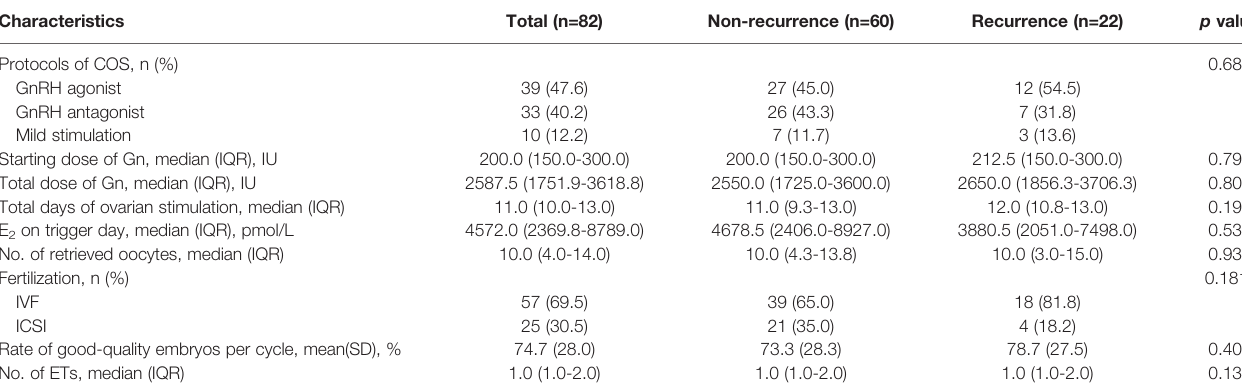
TABLE 4 | Protocols of COS and data of IVF of 82 EC/AEH patients treated with single COS cycle. Characteristics Total (n=82) Non-recurrence (n=60) Recurrence (n=22) p value Protocols of COS, n